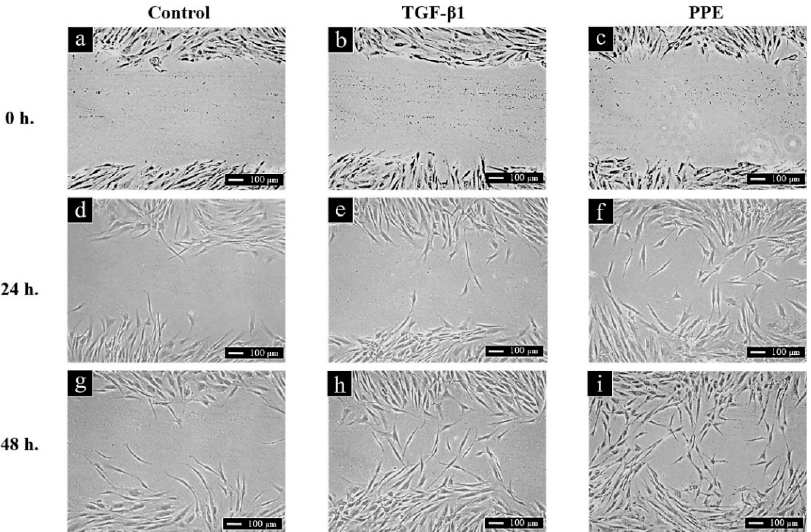
Figure 4. The width of the scratch area of control NHF cells (untreated cells) ( a , d , g ), TGF- β 1 treated NHF cells ( b , e , h ), and 1000 µg/mL PPE treated NHF cells ( c , f , i ) at 0, 24, and 48 h after treatment.